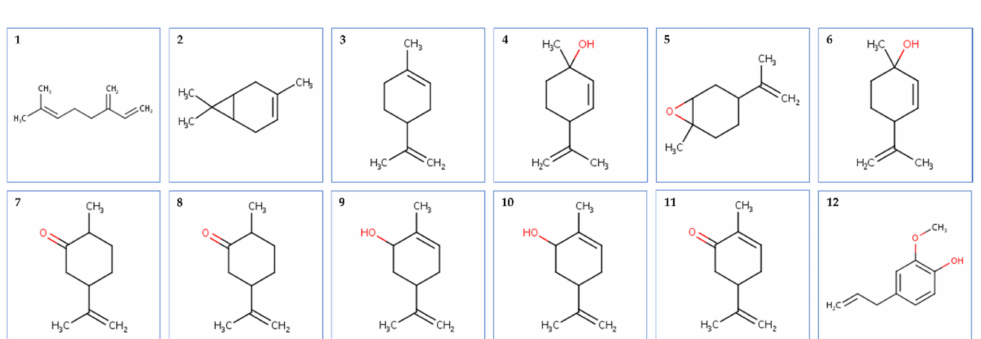
Figure 1. Structure of phytocompounds identified by GC-MS technique from caraway essential